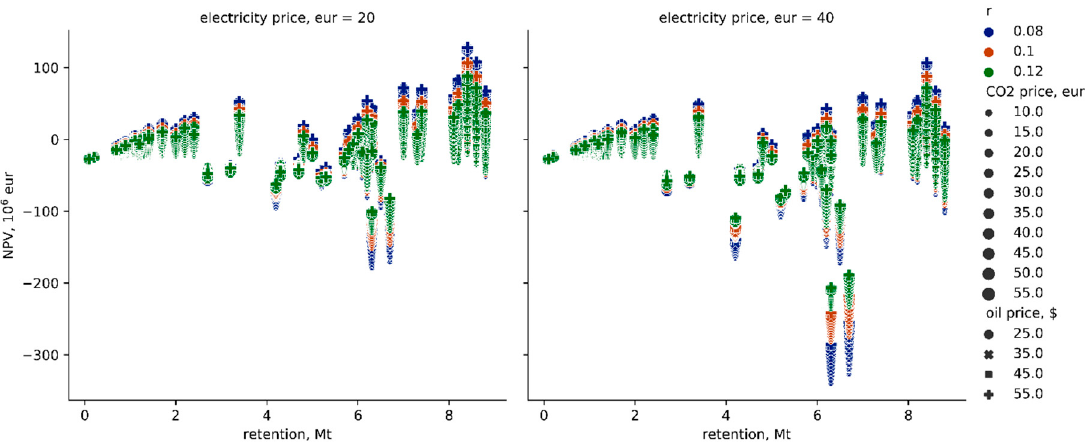
Figure 18. NPV versus retention after 15 years of CO 2 EOR for different discount rates, oil and CO 2 prices, and two different